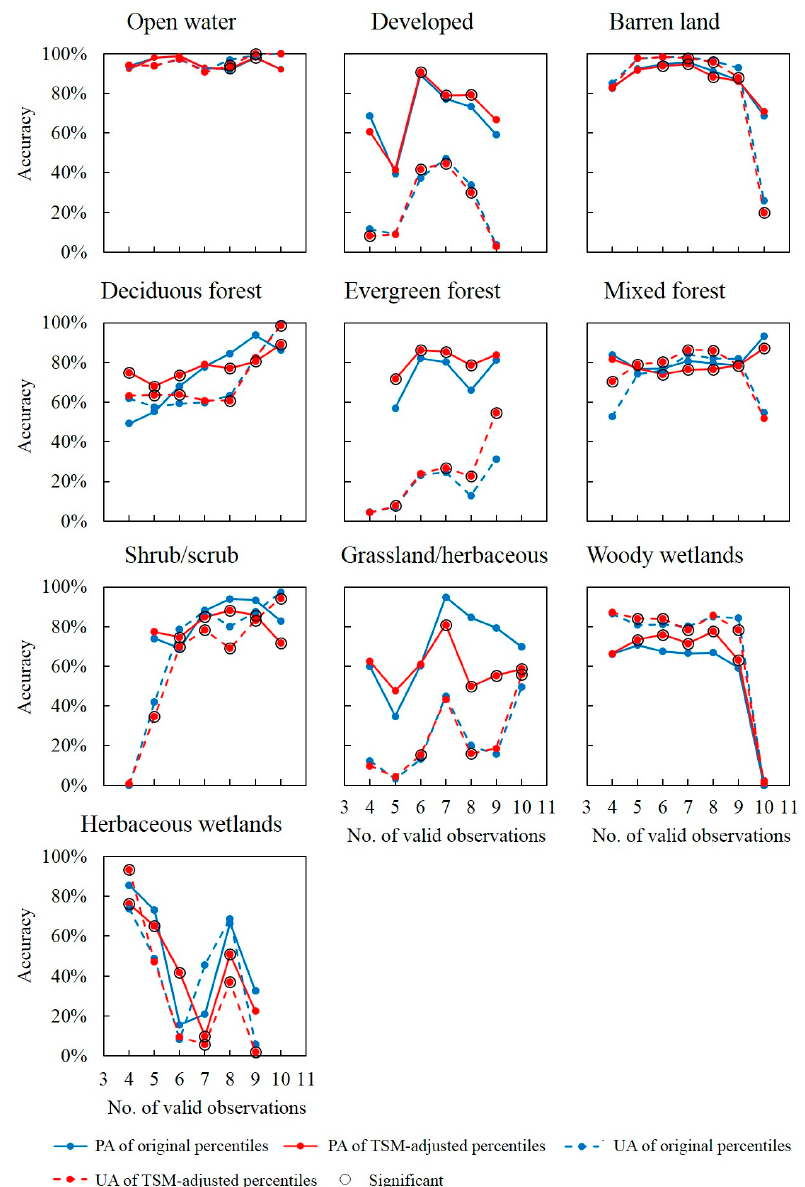
Figure 10. The average PA and UA of each land cover type against the number of valid observations in Minnesota study area. Note that the black circles indicate that the accuracies obtained using the TSM-adjusted percentiles are significantly (at the 5% level) di ff erent from the accuracies obtained using the original